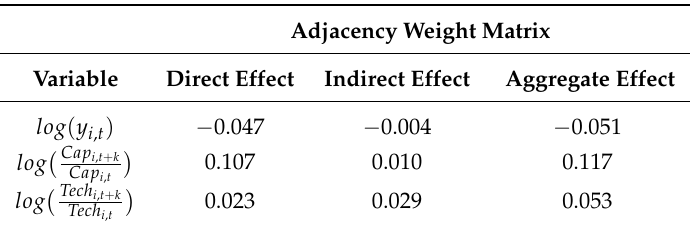
Table 9. Direct, indirect, and cumulative effects for Durbin